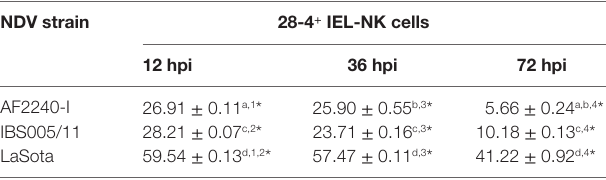
FigUre 3 | Flow cytometry histogram profile for isotype control (red line); before enrichment (black line) and after enrichment (green line) for 28-4 + IEL-NK cells from uninfected control chickens (day 0) and Newcastle disease virus challenged (after 12 hpi of AF2240-I, IBS005/11, and LaSota). The histogram was gated based on propidium iodide population that representing ~90% of the total population of IEL cells. The value was the means ± SEM of three experiments.